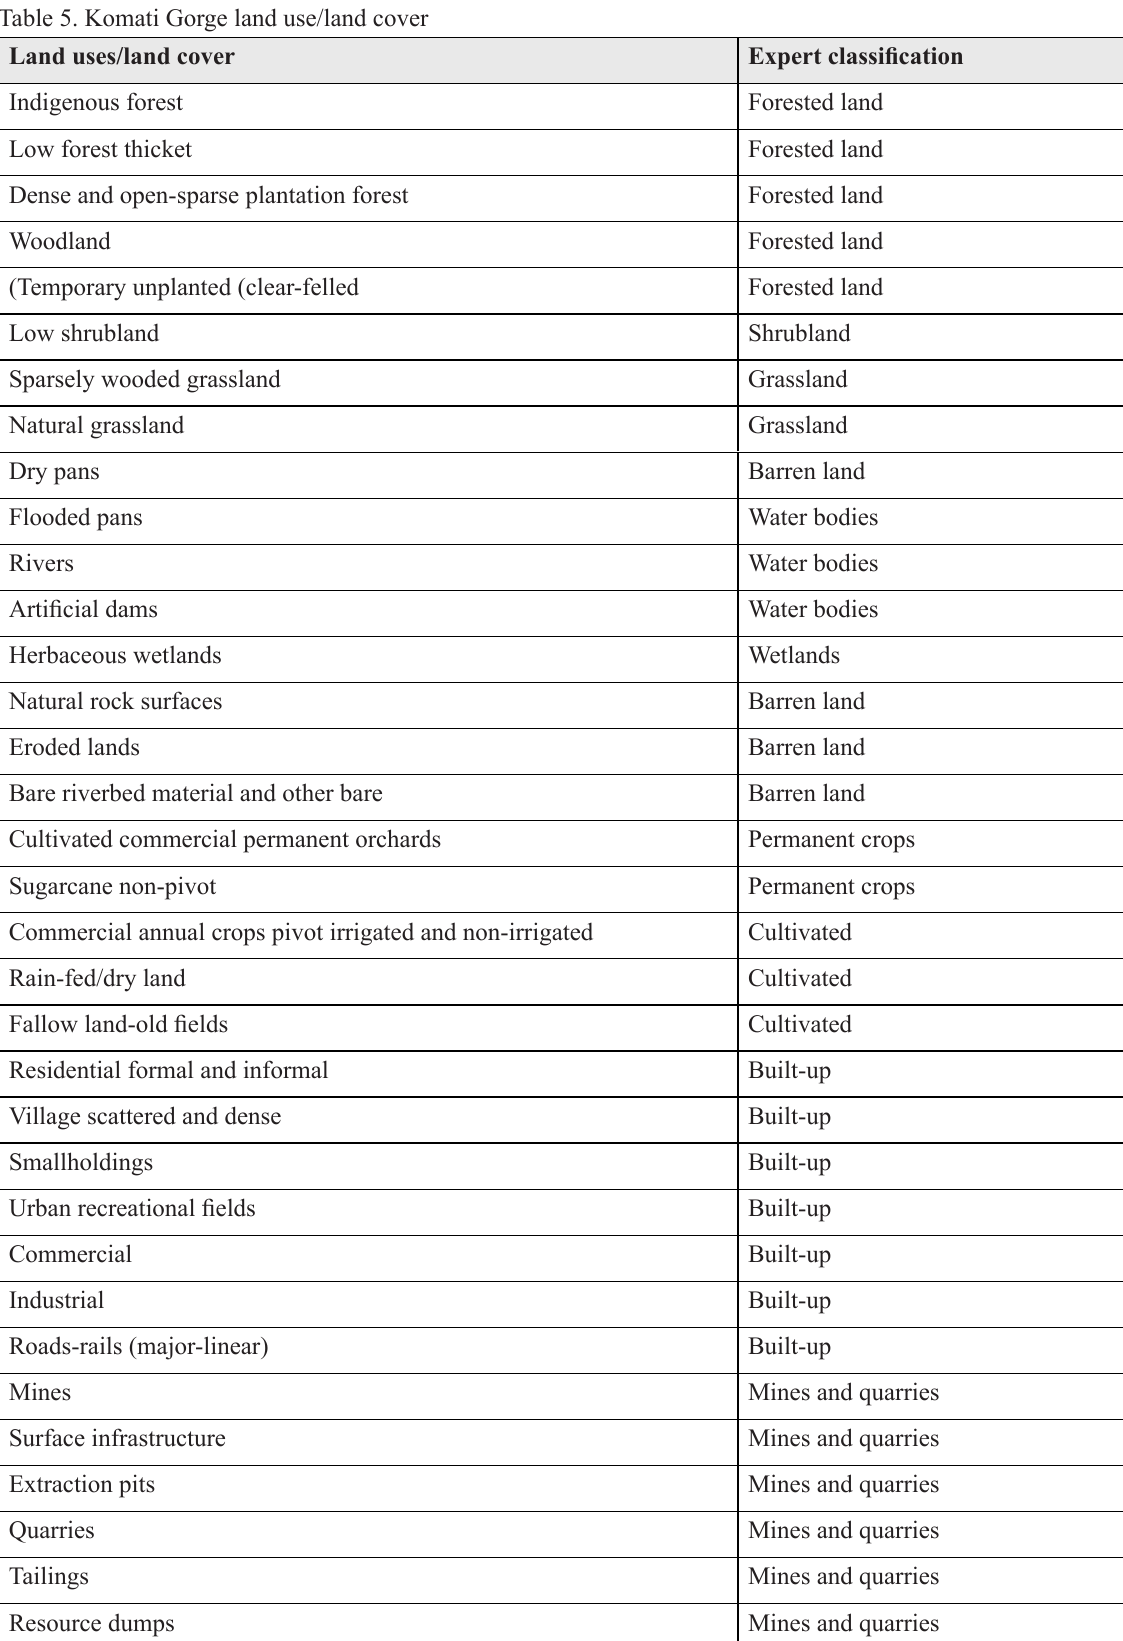
Table 5. Komati Gorge land use/land